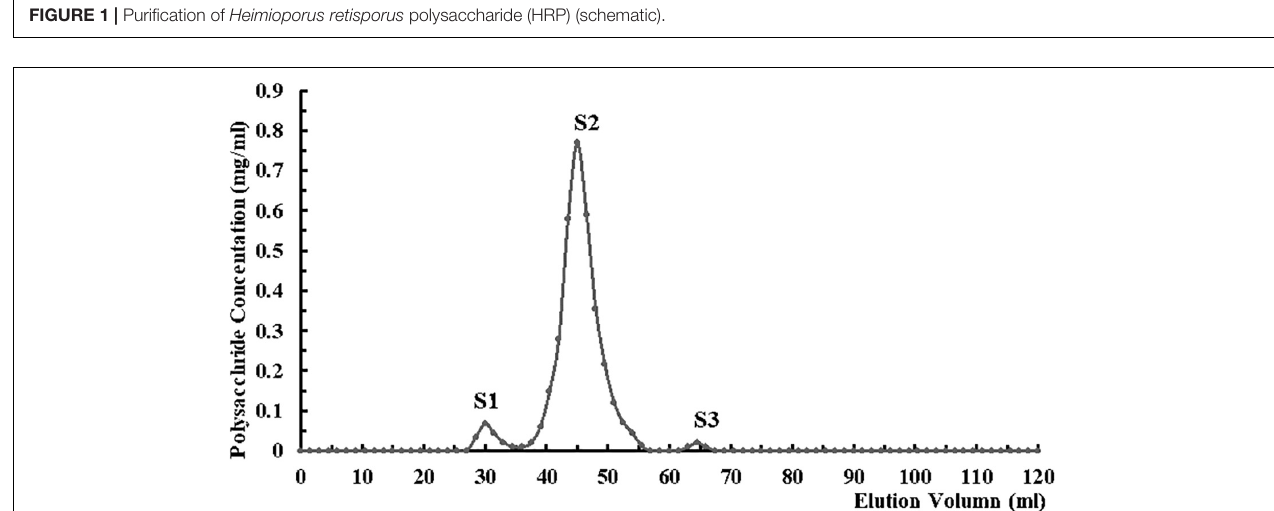
FIGURE 2 | Purification of Heimioporus retisporus Polysaccharide (HRP) on Superdex 75 16/600 gel filtration column by fast protein liquid chromatography (FPLC). Eluent: 0.15 mol/L NaCl in 0.05 mol/L phosphate buffer (pH 7.5). Flow rate: 0.5 mL/min. Fraction S2: purified polysaccharide